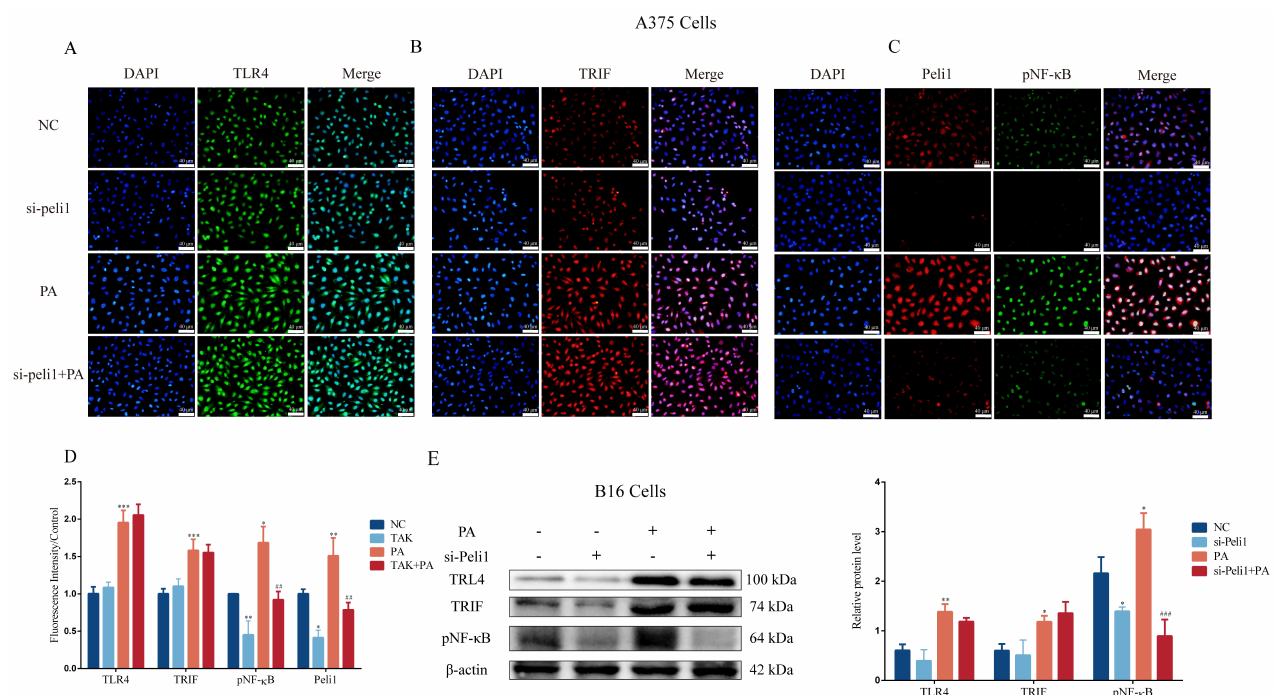
Figure 7. The fluorescence intensity and protein expression of TLR4/TRIF-Peli1-NF- κ B pathway after si-Peli1. ( A ) The fluorescence intensity of TLR4 in A375 cells. ( B ) The fluorescence intensity of TRIF in A375 cells. ( C ) The fluorescence intensity of Peli1 and pNF- κ B in A375 cells. ( D ) Quantitative analysis of fluorescence intensity. ( E ) The protein blots and quantitative analysis of TLR4, TRIF, and pNF- κ B in B16 cells. In A375 and B16 cells, treatment with PA or si-Peli1 (+) and no treatment with PA or si-Peli1 (-). * p < 0.05, ** p < 0.01, or *** p < 0.001 compared with the control group. ## p < 0.01 or ### p < 0.001 compared with the PA group; the significance of the